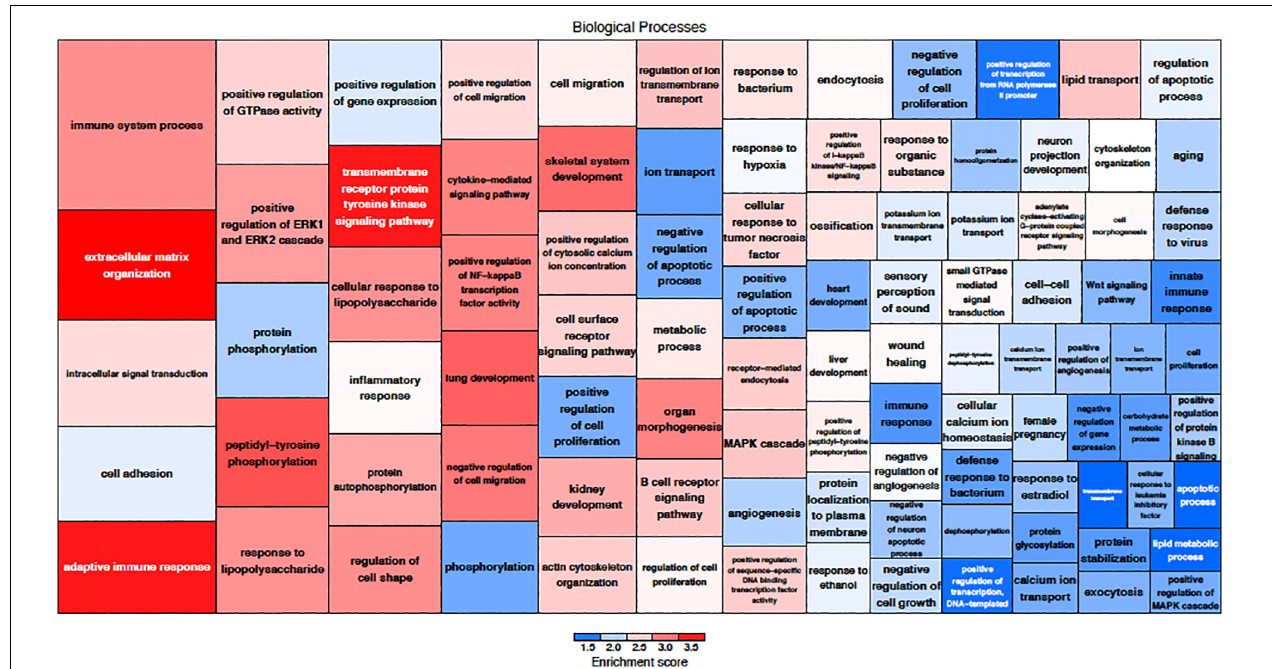
FIGURE 5 | Up-regulated biological processes classified by gene ontology. The size of the category corresponds to a lower FDR with the more deeply red groups representing a higher enrichment score. Up-regulation of genes related to immune function are a key component of MSC treatment.